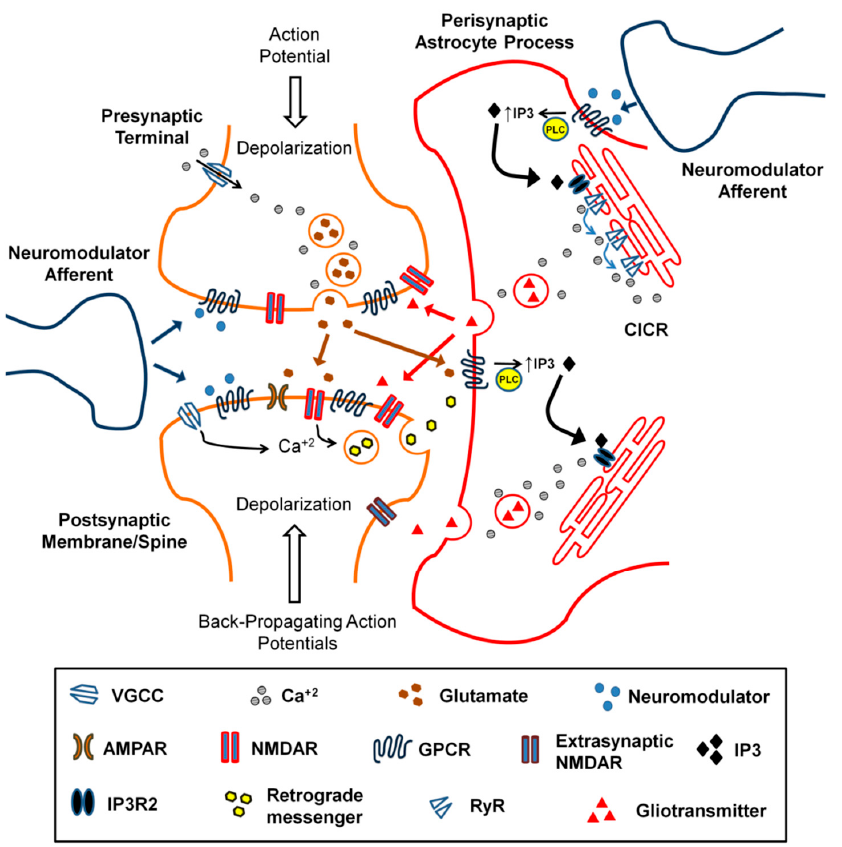
Figure 2. A schematic representation of astrocytic synaptic coverage and neuromodulatory inputs. Astrocytes are able to detect and respond to both synaptic activity and neuromodulatory afferent signals. Neuromodulators and neuron-released transmitters (presynaptic and postsynaptic retrograde messengers) activate associated receptors on perisynaptic astrocyte processes leading to intracellular calcium signalling and subsequent induction of gliotransmitter release to modulate local activity and synaptic plasticity. Similarly, neuromodulatory signals can target neurons, astrocytes or both; hence, neuromodulators transmit behaviour-related signals to induce neuronal activity directly and/or through astrocytes.